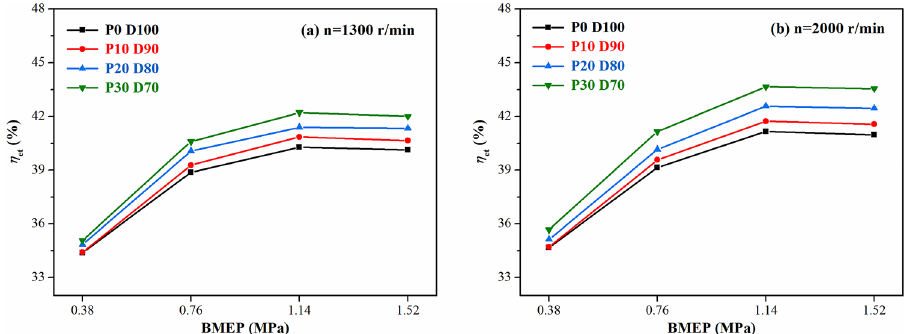
Figure 8. Effects of PODE n blending ratio on effective thermal efficiency.